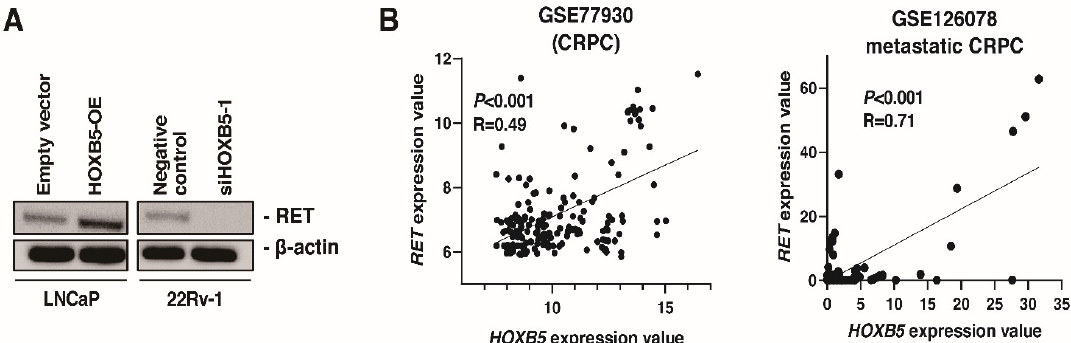
Figure 4. The association between HOXB5 and RET in prostate cancer (PCa). ( A ) Western blotting of RET in LNCaP cells transfected with HOXB5 expressing vector and empty vector and 22Rv-1 cells transfected with HOXB5 or negative control siRNAs. β -actin was used as a loading control. ( B ) The correlation between HOXB5 expression and RET expression in GSE77930 and GSE126078. Spearman’s correlation coefficients and p -values are indicated.